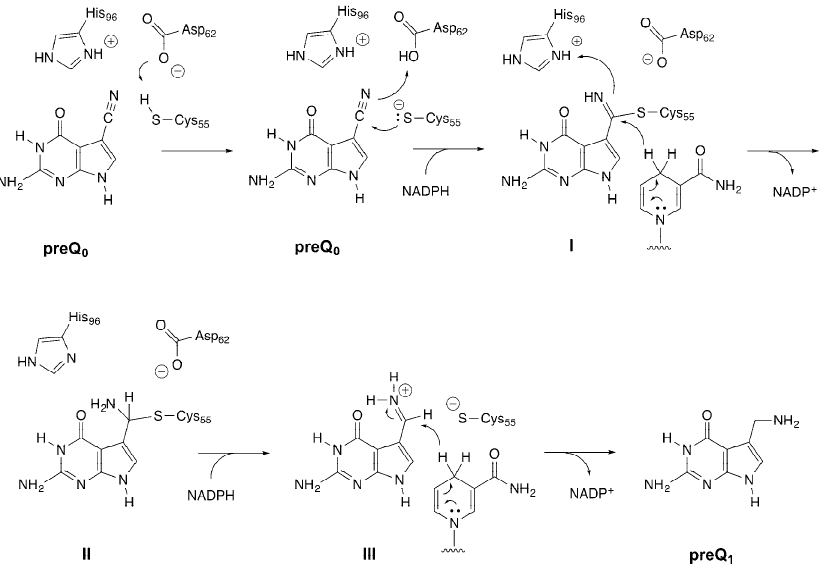
Figure 2. The proposed catalytic mechanism of the QueF catalyzed reaction (amino acid numbering based on the Bacillus subtilis enzyme).